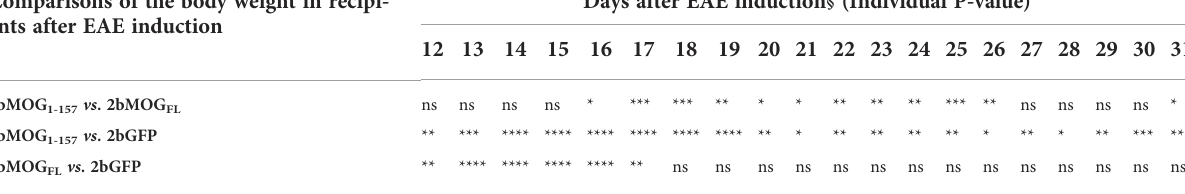
Days after EAE induction § (Individual